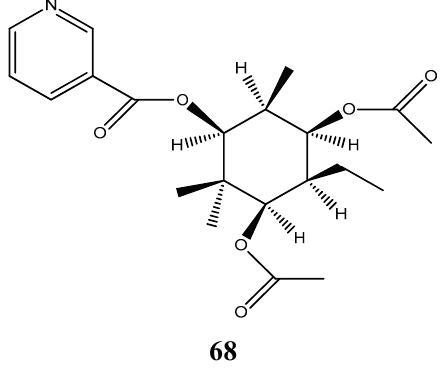
Figure 8. Strucuture of the alkaloid